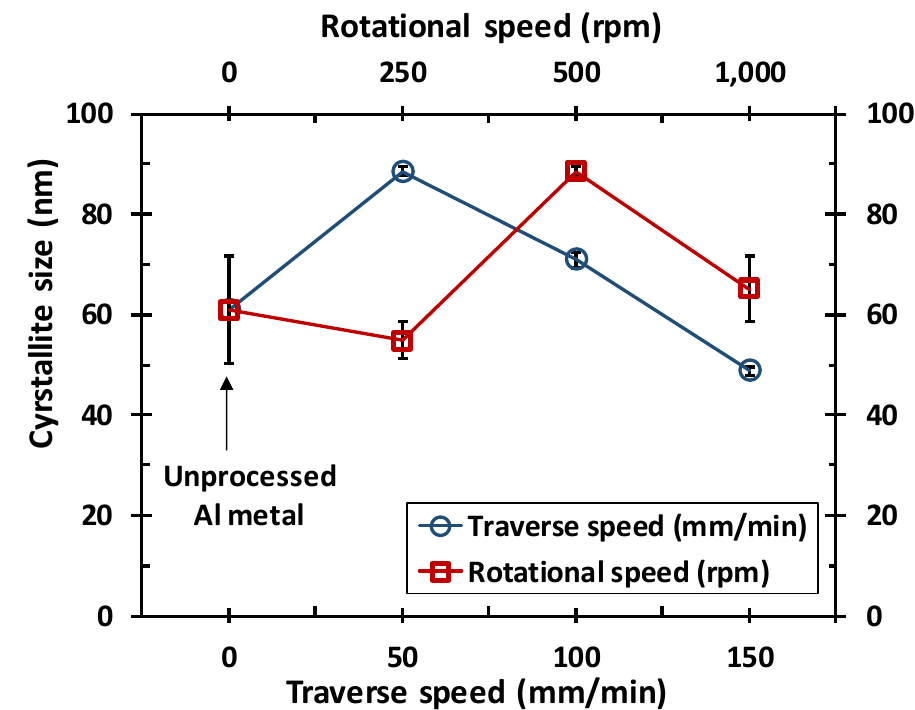
Figure 5. Crystallite size as a function of the traverse and rotation speeds.